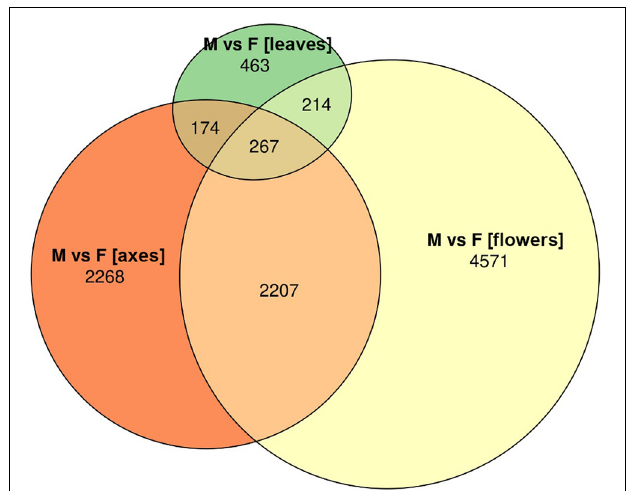
FIGURE 2 | Euler diagram for genes differentially expressed between male and female Populus × sibirica plants in leaves, catkin axes, and flowers. Transcriptome sequencing data; genes with CPM (counts per million) > 8 and at least twofold expression level differences were taken into account; M, male; F,